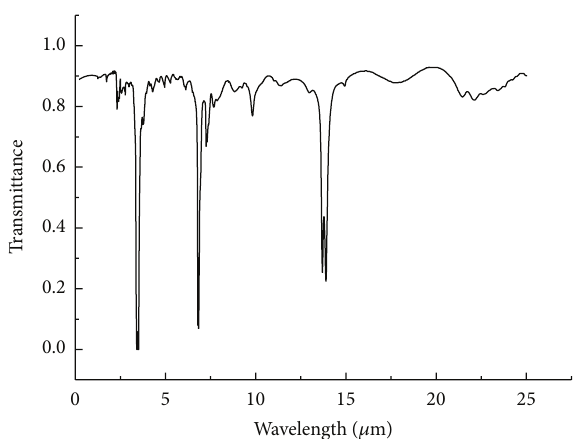
Figure 6: Spectral transmittance of low-density polyethylene film.